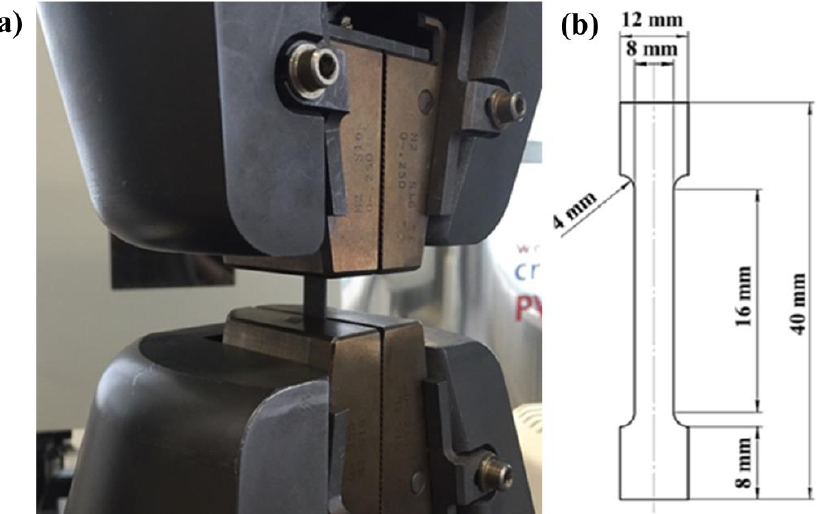
Figure 1. Instron universal static testing system ( a ), schematic diagram of the blade samples for tensile tests ( b ).